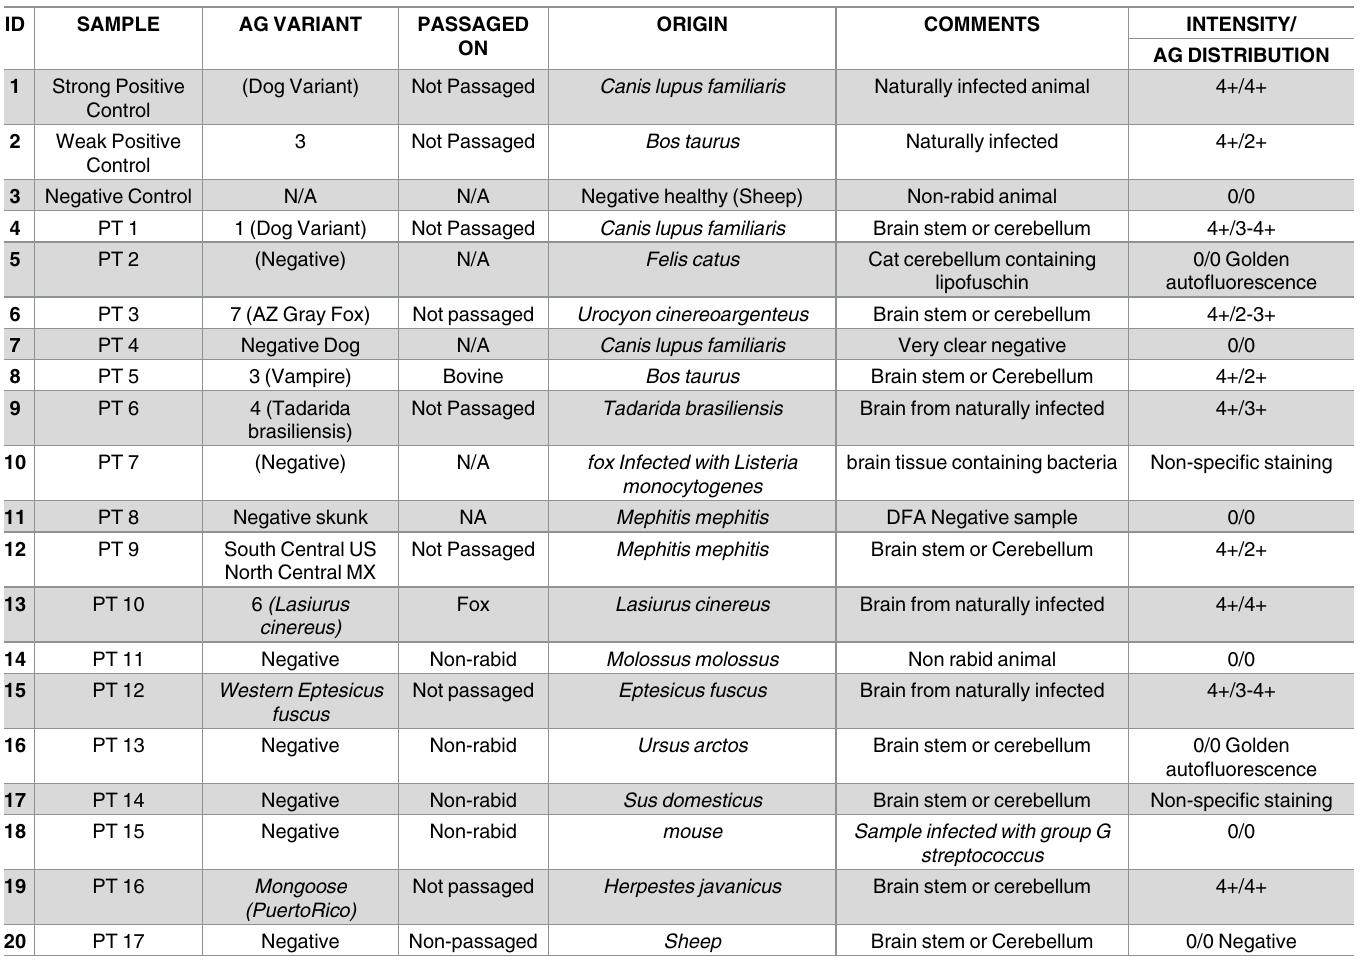
Table 1. Rabies panel composition and rabies virus variants used in this